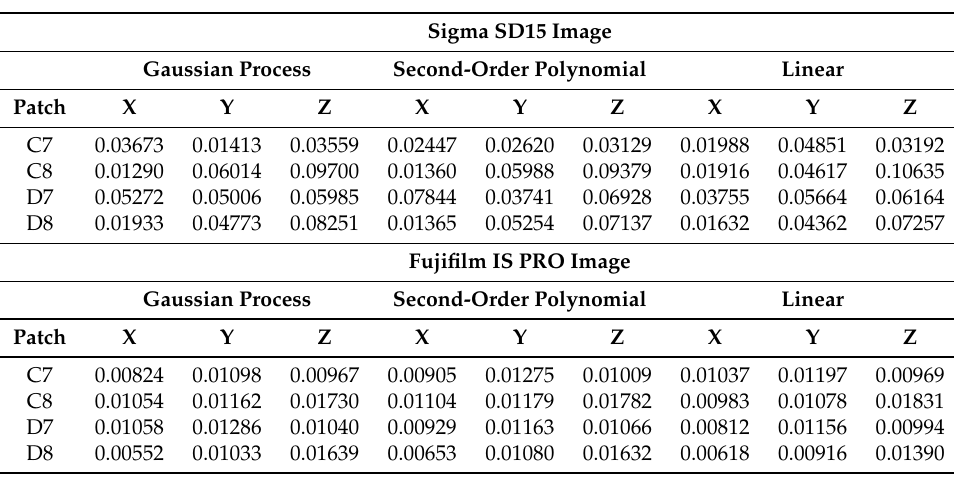
Table 5. Variation coefficients of the output CIE XYZ